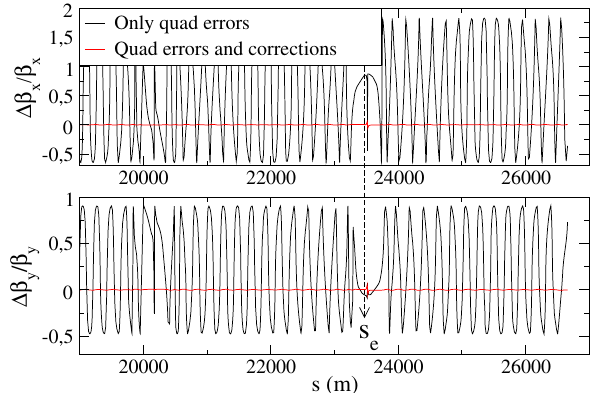
FIG. 5. β beating due to quadrupole errors introduced in the LHC lattice in IR1 (black), and the effect of adding the corrections of Table I to the same lattice (red).